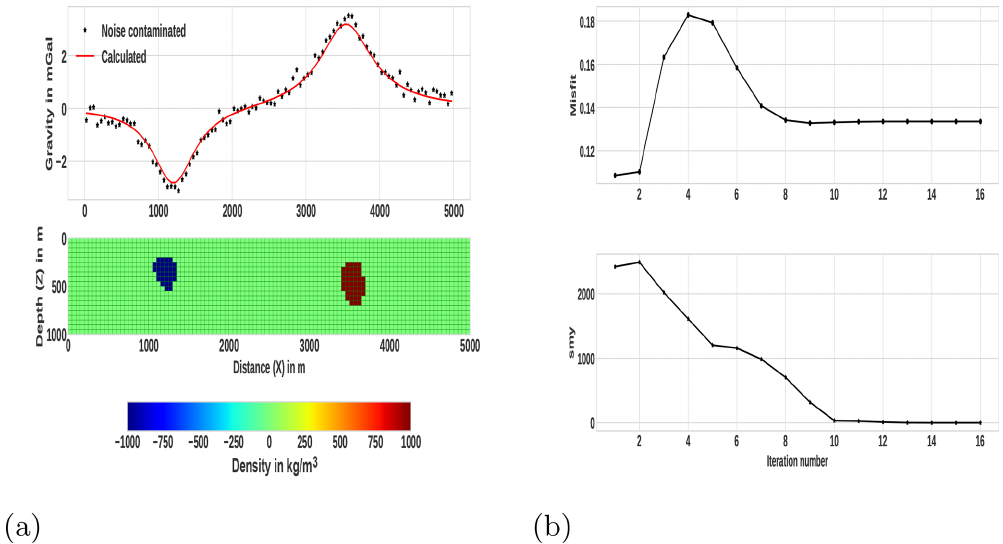
Figure 11. Late-iteration-termination (at 16th iteration) inversion result and the corresponding misfit and smy variations, with the iteration number for the fourth example in Fig. 8. (a) The obtained recovered density model (lower panel) and the corresponding data fit (upper panel). (b) Progression of misfit (top panel) and smy (lower panel) in the course of the iterative